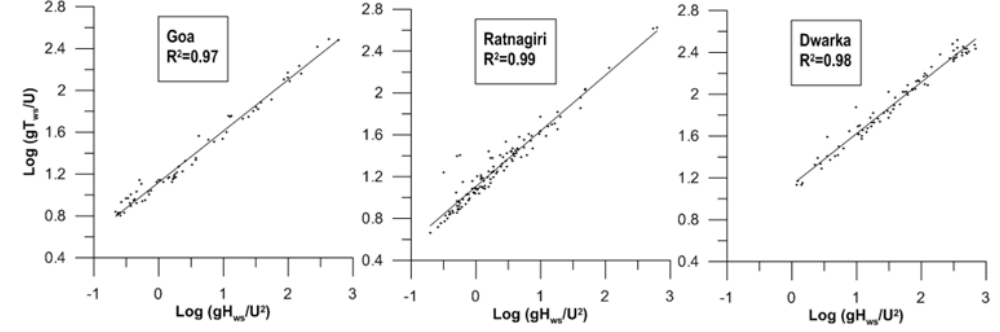
Fig. 9. Scatter between log (gH Sws /U 2 ) and log (gT Pws /U) at different locations along the west coast of